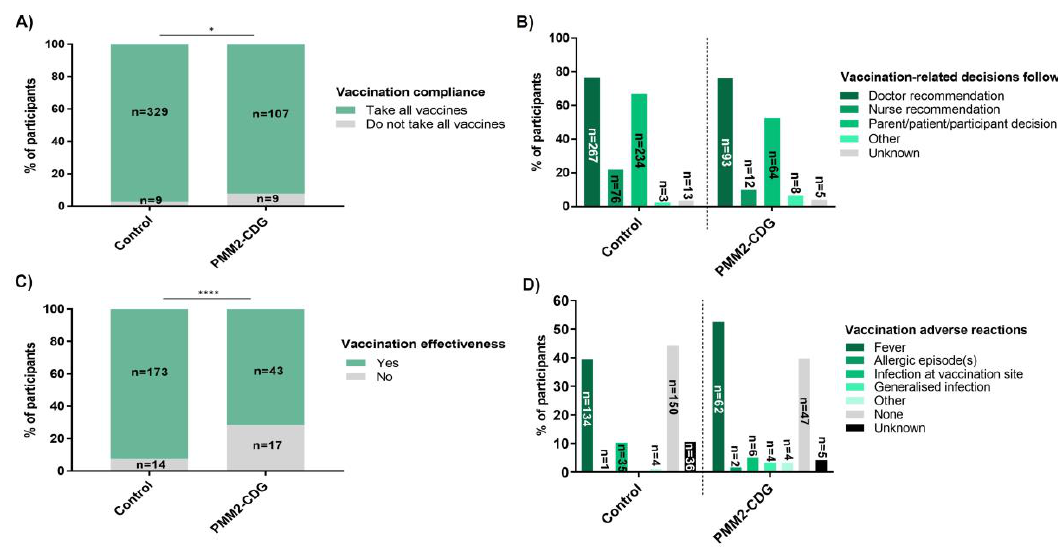
Figure 7. Vaccination compliance, e ff ectiveness, safety and decision-making. ( A ) Vaccination compliance. Participants were asked if they had taken all vaccines available to them. Statistical significance refers to the comparison between participants who reported having taken all vaccines and those who said they had not in PMM2-CDG vs. controls ( p = 0.024 (*) / OR = 3.07). Participants unaware or uncertain of having taken all vaccines were excluded from this analysis; ( B ) Players involved in vaccination-related decision-making. When compared to the controls, PMM2-CDG participants relied significantly less on nurses’ recommendation ( p = 0.0029 / OR = 0.39) and on parent / participant judgement ( p = 0.0046 / OR = 0.54). Statistical significance refers to the comparison between participants who reported following nurses’ recommendations or parent / participant judgement against those who did not; ( C ) Vaccination perceived (in)e ff ectiveness. Statistical significance refers to the comparison between participants assessing vaccination as e ff ective and those describing it as ine ff ective ( p = 8.339 × 10 − 5 (****) / OR = 4.85). Participants who were unaware of or uncertain about the (in)e ff ectiveness of vaccination were omitted from this analysis; ( D ) Specific vaccination adverse reactions (ADRs). In total, PMM2-CDG did not report significantly more vaccination-associated ADRs, except for fever ( p = 0.017 / OR = 1.69). Statistical significance refers to the comparison between participants identifying vaccination-triggered fever and those who did not. In the “Other” category for controls were included edema at the vaccination site ( n = 2 / 339), muscular pain with tetanus associated with a yellow fever vaccine ( n = 1 / 339) and faintness and transient vision / hearing loss ( n = 1 / 339) after every dose of human papilloma virus (HPV) vaccine. For PMM2-CDG in the “Other” group, seizures ( n = 1 / 118), stroke-like episodes ( n = 1 / 118) and, two patients were reported to have become extremely upset, limp and required medical help. All statistical significance was calculated with Fisher’s exact test.